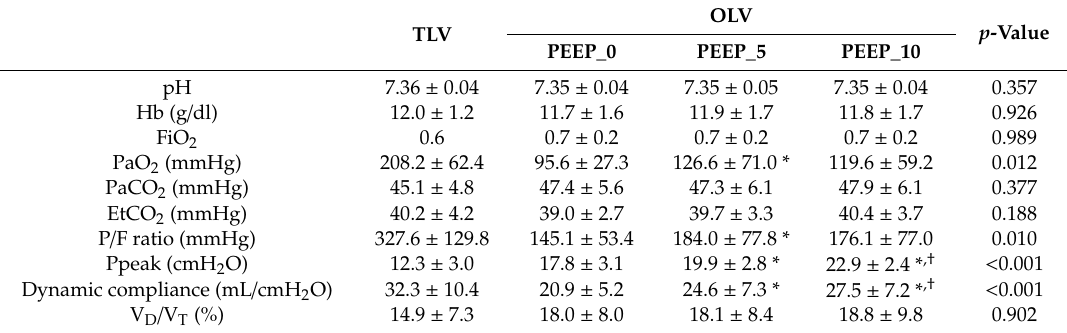
Values are expressed as mean ± SD. * p < 0.05 vs. PEEP_0; † p < 0.05 vs. PEEP_5. Hb, hemoglobin; PaO 2 , arterial oxygen partial pressure; PaCO